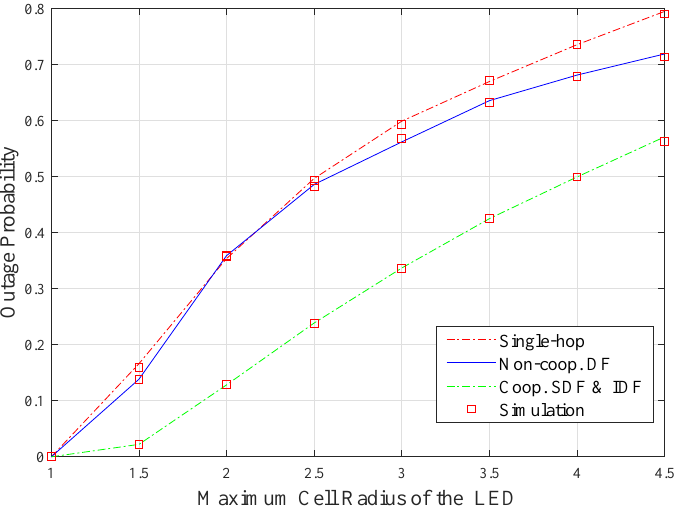
Figure 7. Performance comparison between the different VLC system setups as a function of VLC cell radius.